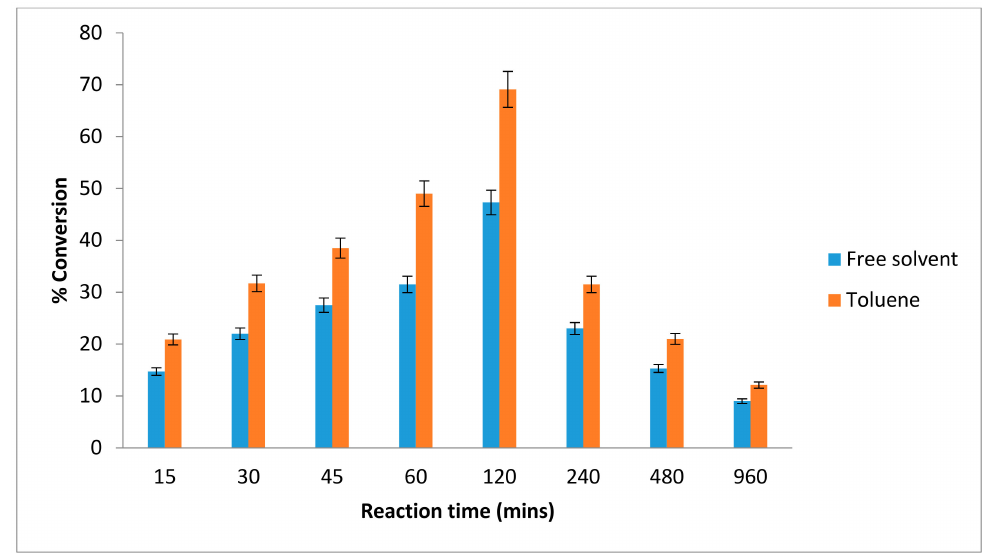
Figure 3. Effect of various reaction times on lipAMS8 lipase in toluene and free-solvent-system. Percentage conversion of ethyl hexanoate catalysed by native lipAMS8 lipase as affected different reaction of time in toluene and free-solvent system. Reactions were performed at 20 ◦ C with 1:1 molar ratio of hexanoic acid to